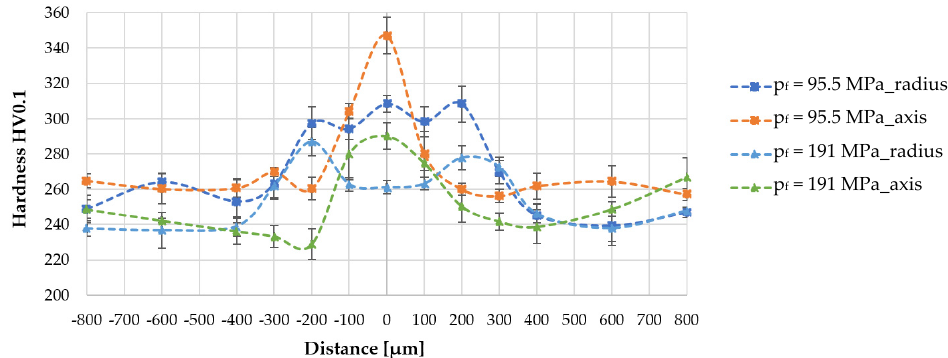
Figure 9. Hardness distribution of high-speed friction welded joints made of S2335JR steel.